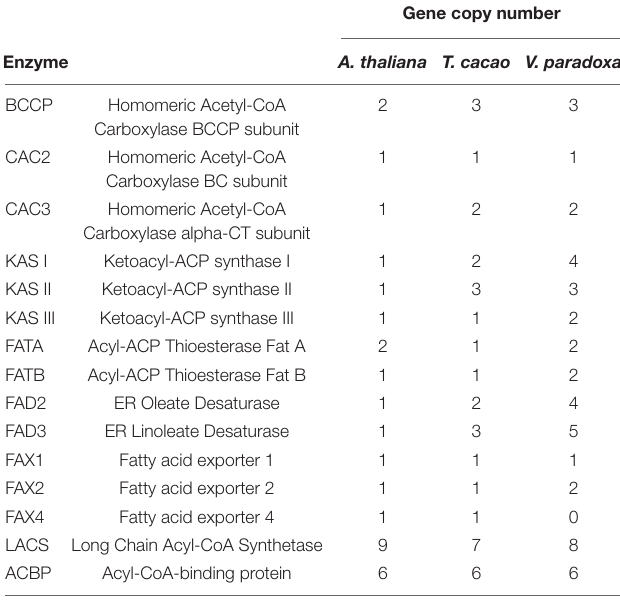
TABLE 4 | Summary table of gene copy numbers of enzymes involved in fatty acid biosynthesis in Arabidopsis thaliana , Theobroma cacao , and Vitellaria paradoxa , using 30 A. thaliana genes as queries.